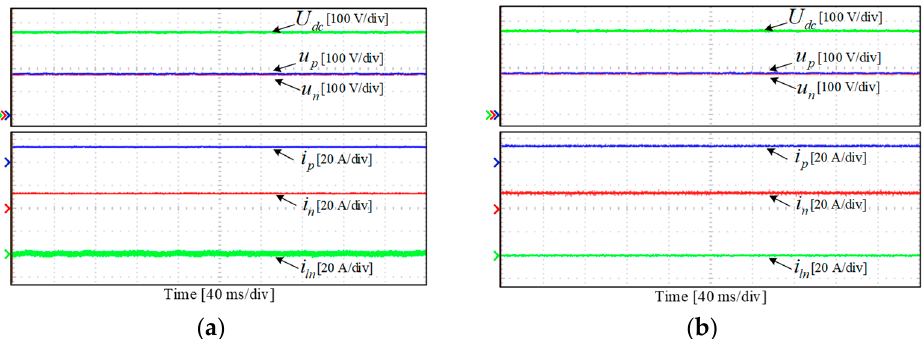
Figure 11. Experimental results of different DPC strategies under a balanced load condition. ( a ) Classic DPC strategy and ( b ) proposed DPC strategy.